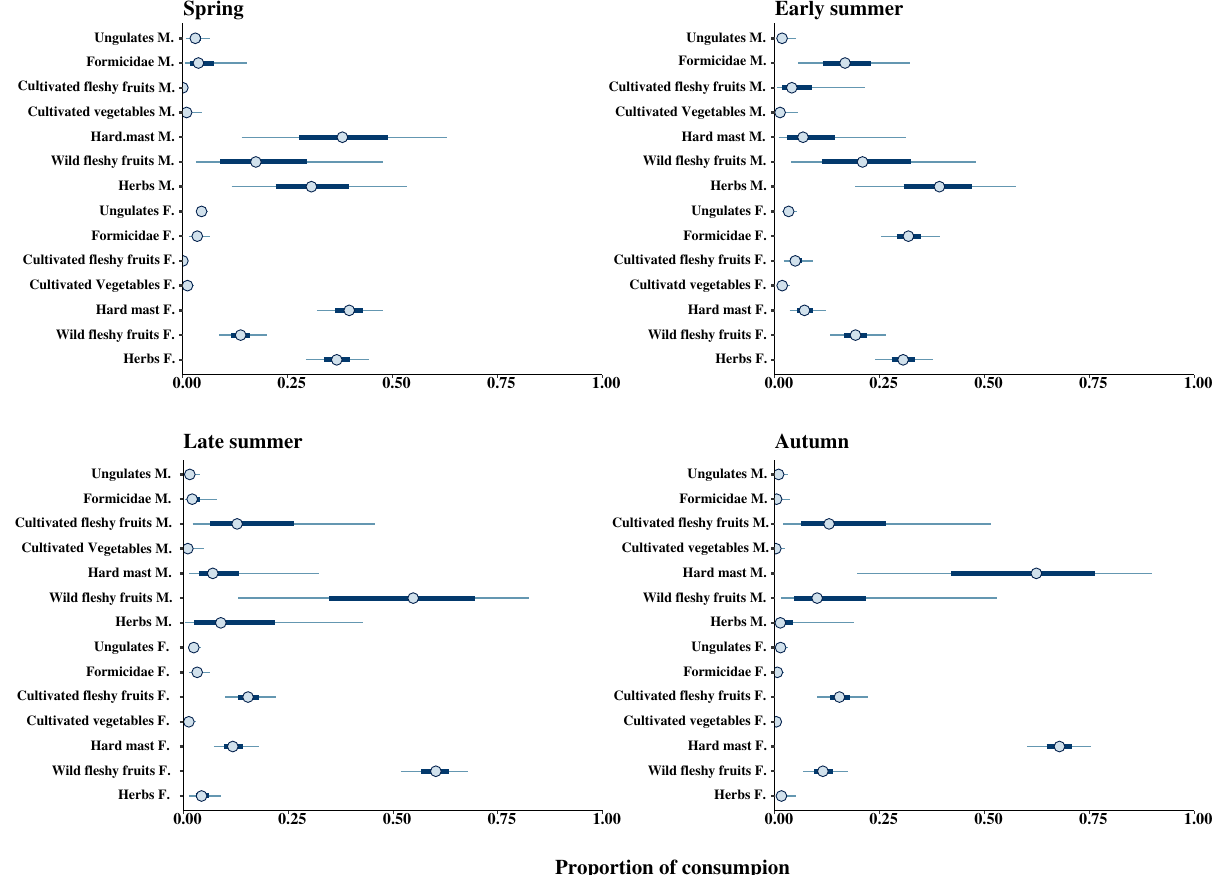
Figure 3. Mean estimated posterior proportional dietary contribution for male (M) and female (F) Apennine Brown bears in the four dietary seasons (Abruzzo Lazio and Molise National Park, central Italy, June–September 2014). Circles represent the median contribution, of each key-food category, to bears diet, with 95% (thin lines) and 50% (thick lines) credibility